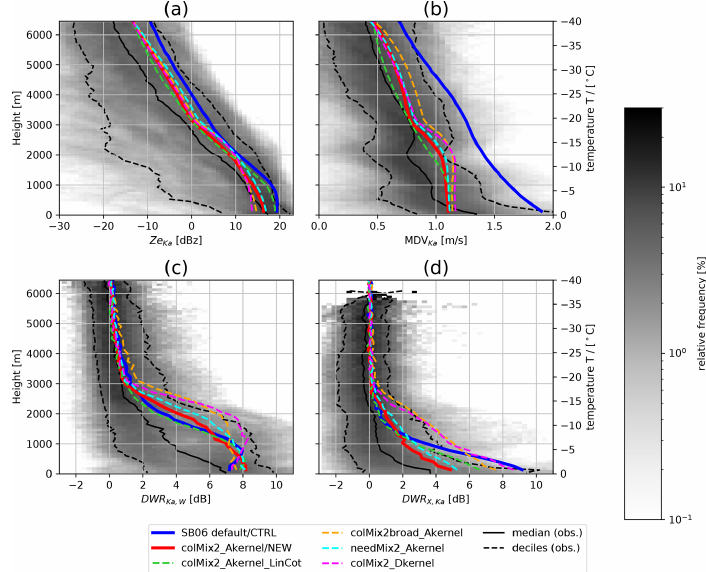
Figure 7. (a) Reflectivity Ze Ka , (b) mean Doppler velocity MDV Ka , (c) DWR Ka,W , and (d) DWR X,Ka . Lines: simulated profiles based on snowshaft simulations (Fig. 6) as well as the median and quartiles of the observations. Greyscale: histogram of observations from the Tripex campaign